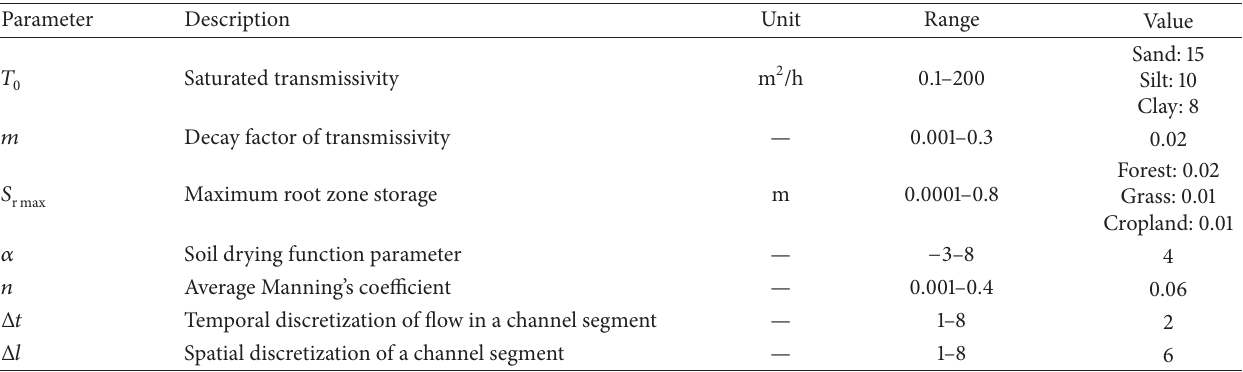
Table 2: Model parameter description.